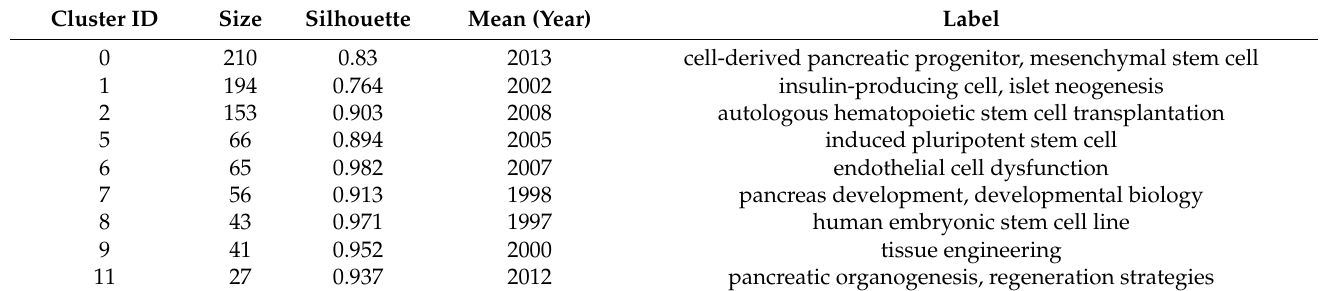
Table 2. Cluster summary of co-citation network.